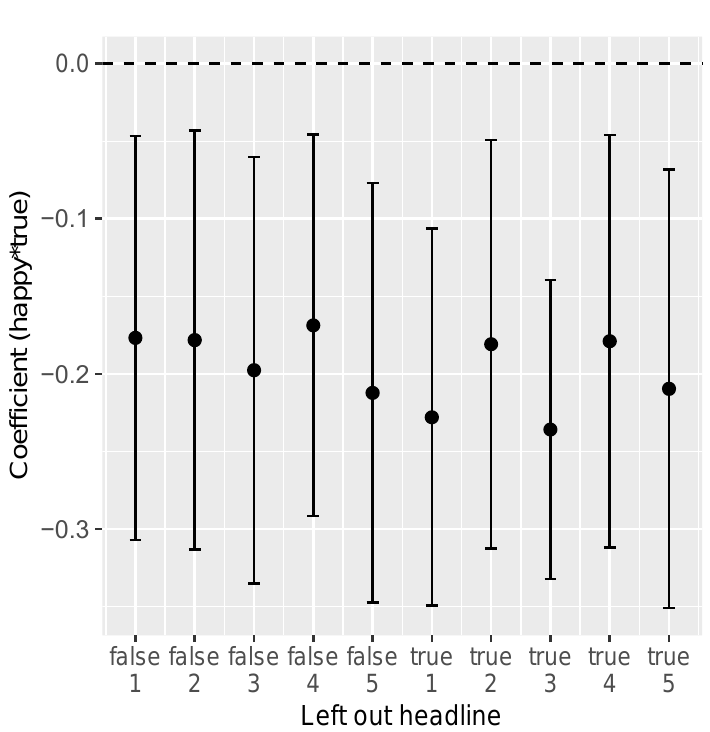
Figure C2. Leave one out analysis –